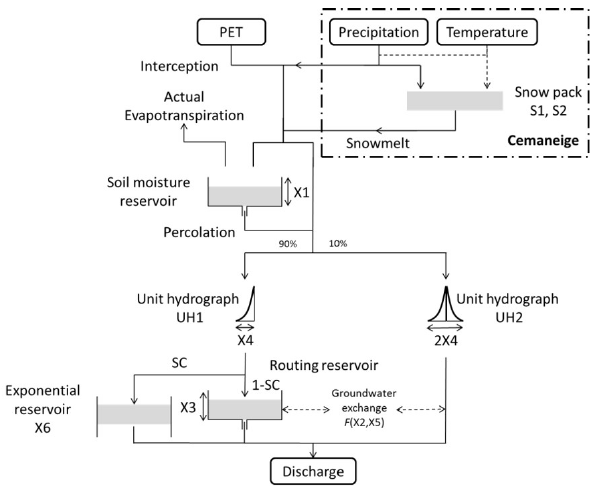
Figure 5. Schematic of the rainfall–runoff model GR6J combined with the CemaNeige snowmelt runoff component (after Pushpalatha et al.,